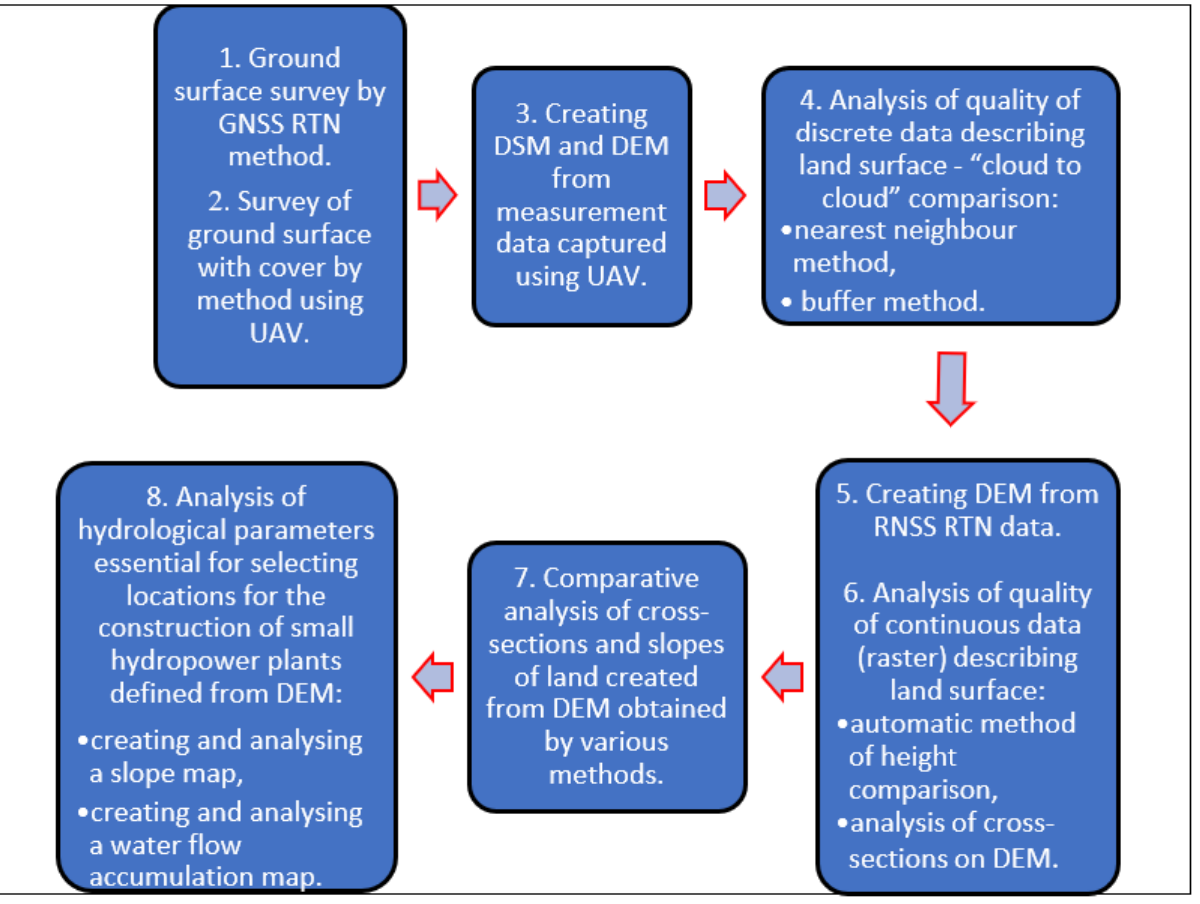
Figure 1. Diagram of the conducted analyses.